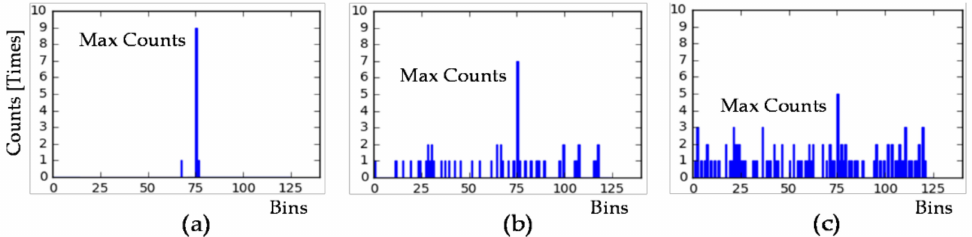
Figure 8. The histograms are built using peak detection method in 10 cycles with three cases: ( a ) SNR = 12 dB; ( b ) SNR = − 5.4 dB; ( c ) SNR = − 9.1 dB.